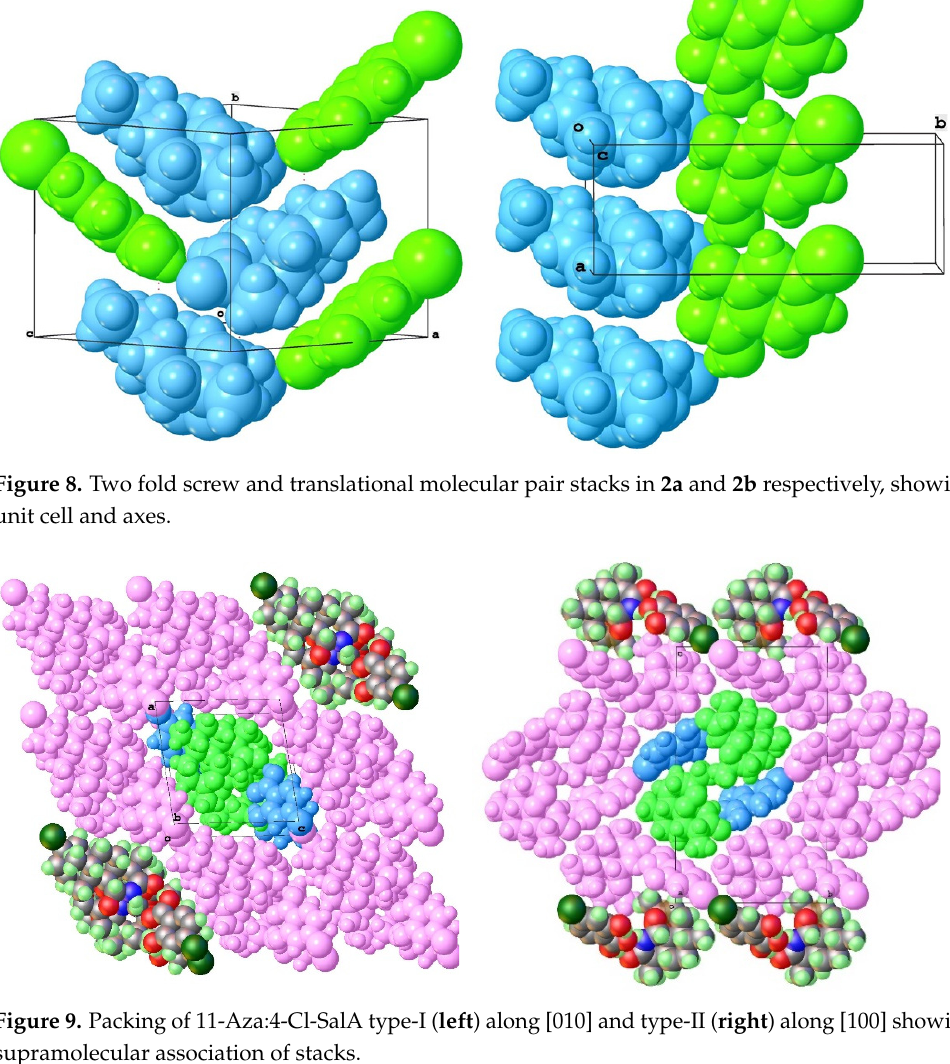
ing supramolecular association of stacks. supramolecular association of